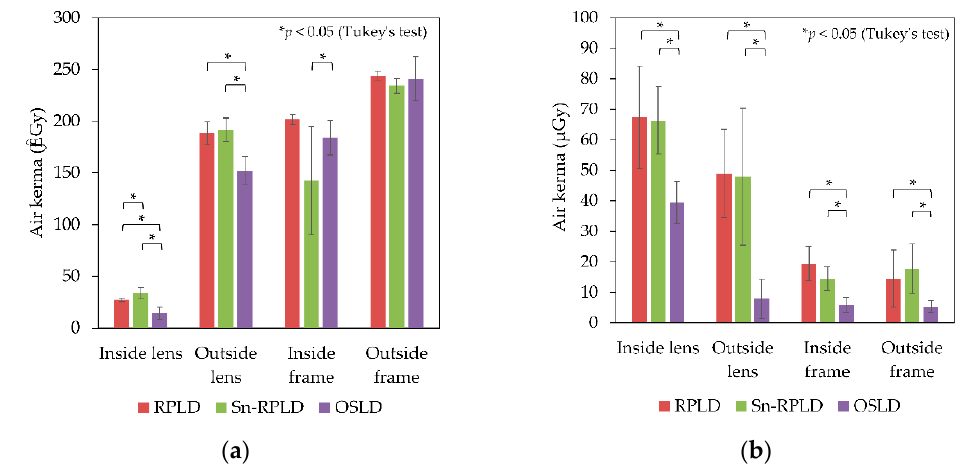
Figure 7. Relative dose values as a function of the dosimeter angle: ( a ) horizontal direction and ( b ) vertical direction.